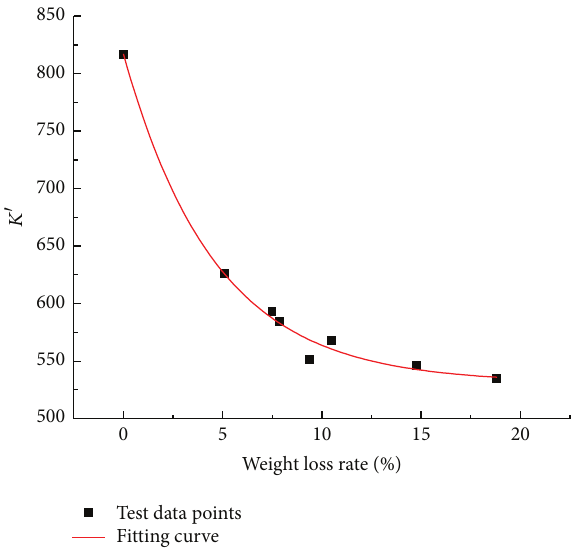
Figure 7: Relationship between recycling intensified factor and weight loss rate.